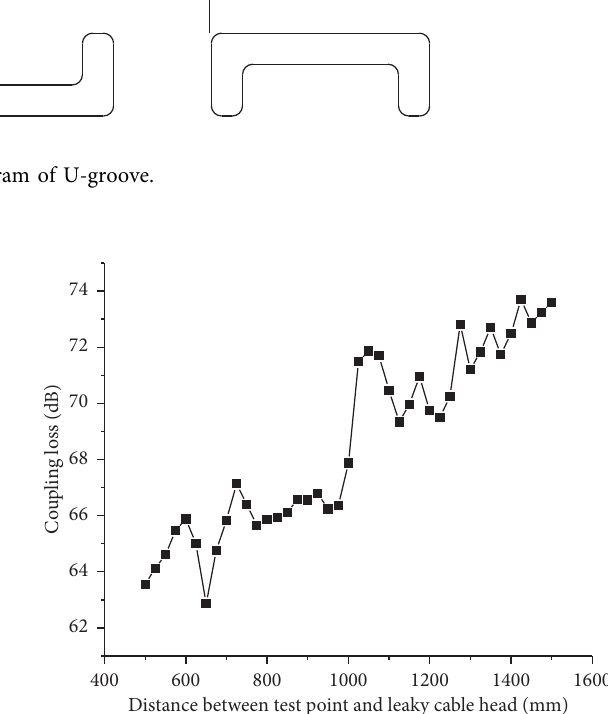
Figure 1: Diagram of U-groove.